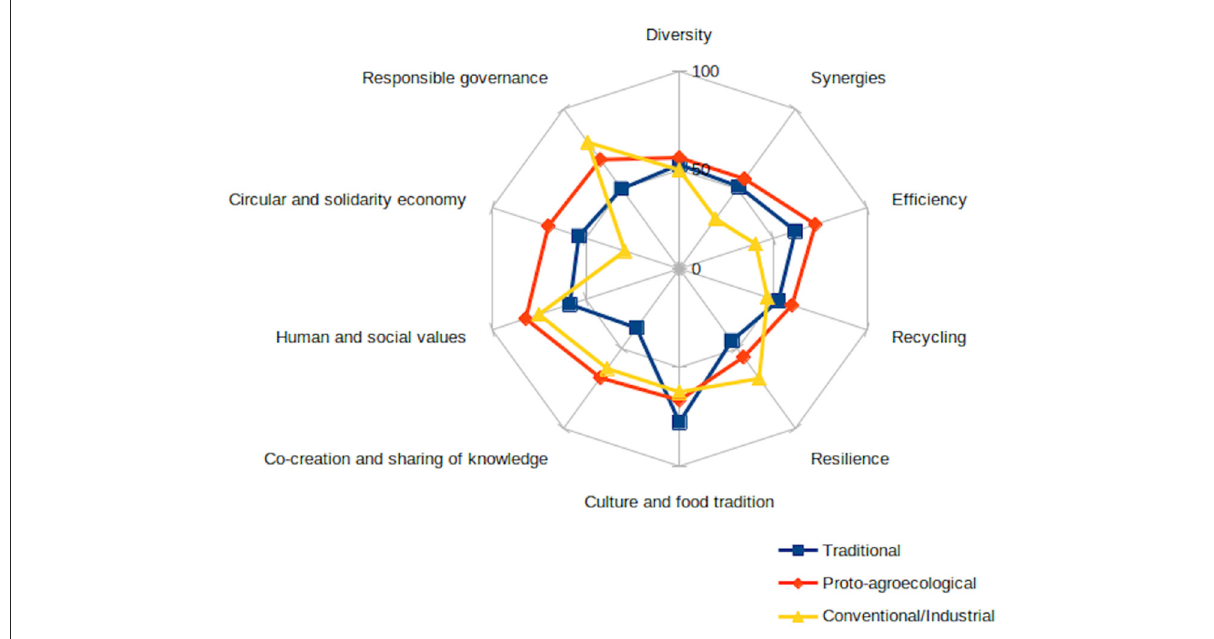
FIGURE3 Results of TAPE—Step 1 according to farm